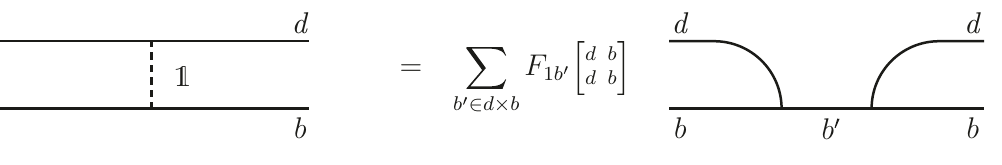
Figure 11 . Partial fusing of a defect d onto a boundary b .